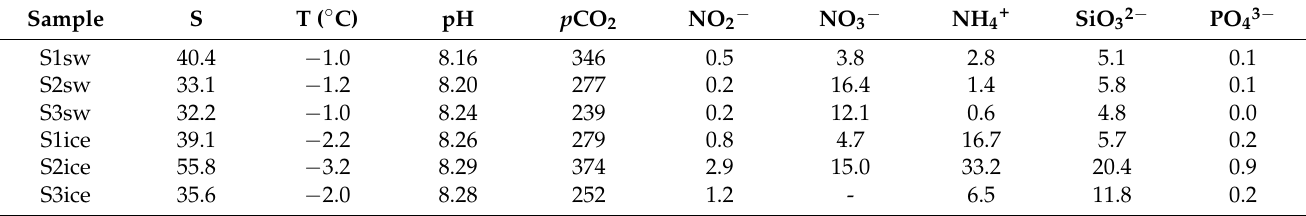
Table 1. Salinity (S), temperature (T), pH, p CO 2 ( µ atm) and nutrient concentrations ( µ mol · kg − 1 ) in the seawater and in the sea ice